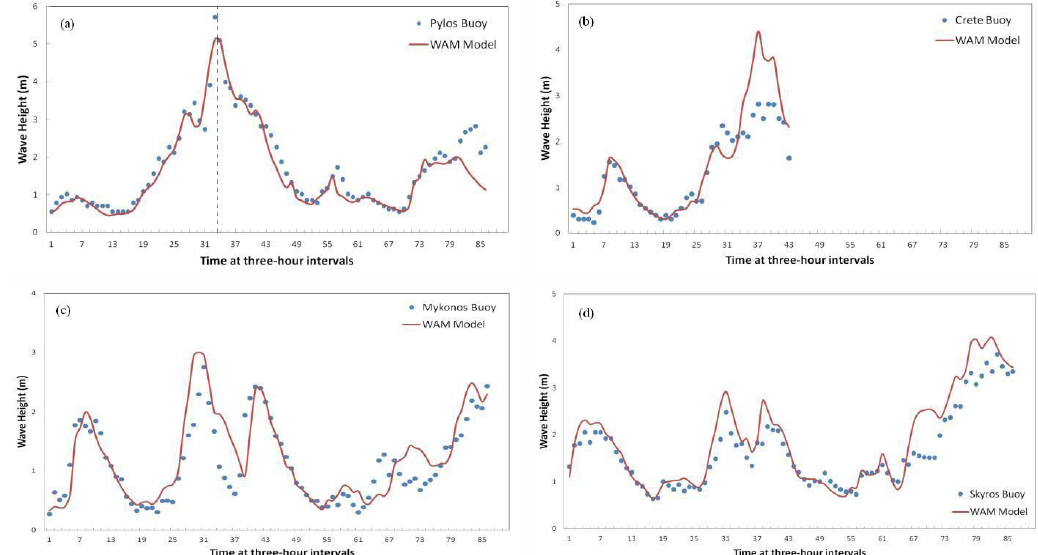
Fig. 6. (a) Time series of significant wave height at Pylos as forecast by WAM model (red line) and measured by the buoy (blue dots). Time ticks at 3-h intervals; 25 correspond to the 03:00UTC of 18 February while 41 correspond to the 03:00UTC of 20 February. The dotted line corresponds to the maximum observed wave height. (b) as in (a) but for Crete. Measurements were available up to 20 February. (c) as in (a) but for Mykonos and (d) as in (a) but for